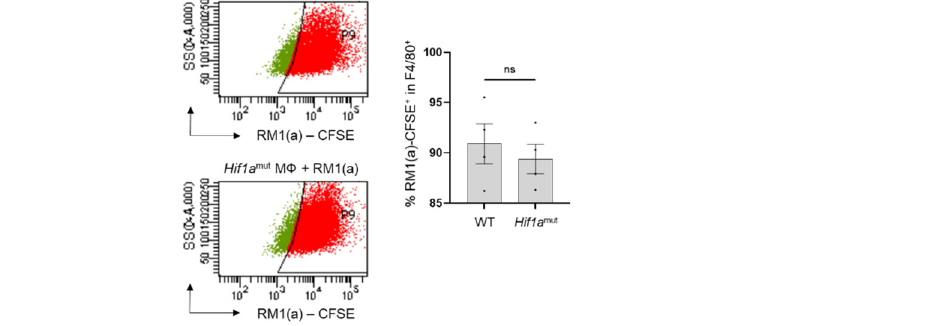
Figure A7. Analysis by flow cytometry of BM macrophages from wildtype and Hif1a mut mice engulfing apoptotic RM1 cells. BM macrophages (M Φ ) were isolated from 4 wk old Hif1a flox/flox (WT), Hif1a mut mice and co-cultured with apoptotic CFSE labeled RM1(a) cells for 16–18 h. Efferocytic macrophages were labeled with F4/80-APC or isotope antibodies and analyzed by flow cytometry. Graph indicates the percentages of efferocytic (F4/80-APC + /RM1(a)-CFSE + (engulfing)) population in WT ( n = 4) and Hif1a mut ( n = 4) BM macrophages. Each plot is representative of cells gated from F4/80 + populations. Plotted data are shown as mean ± SEM, ns = not significant (unpaired t -test).